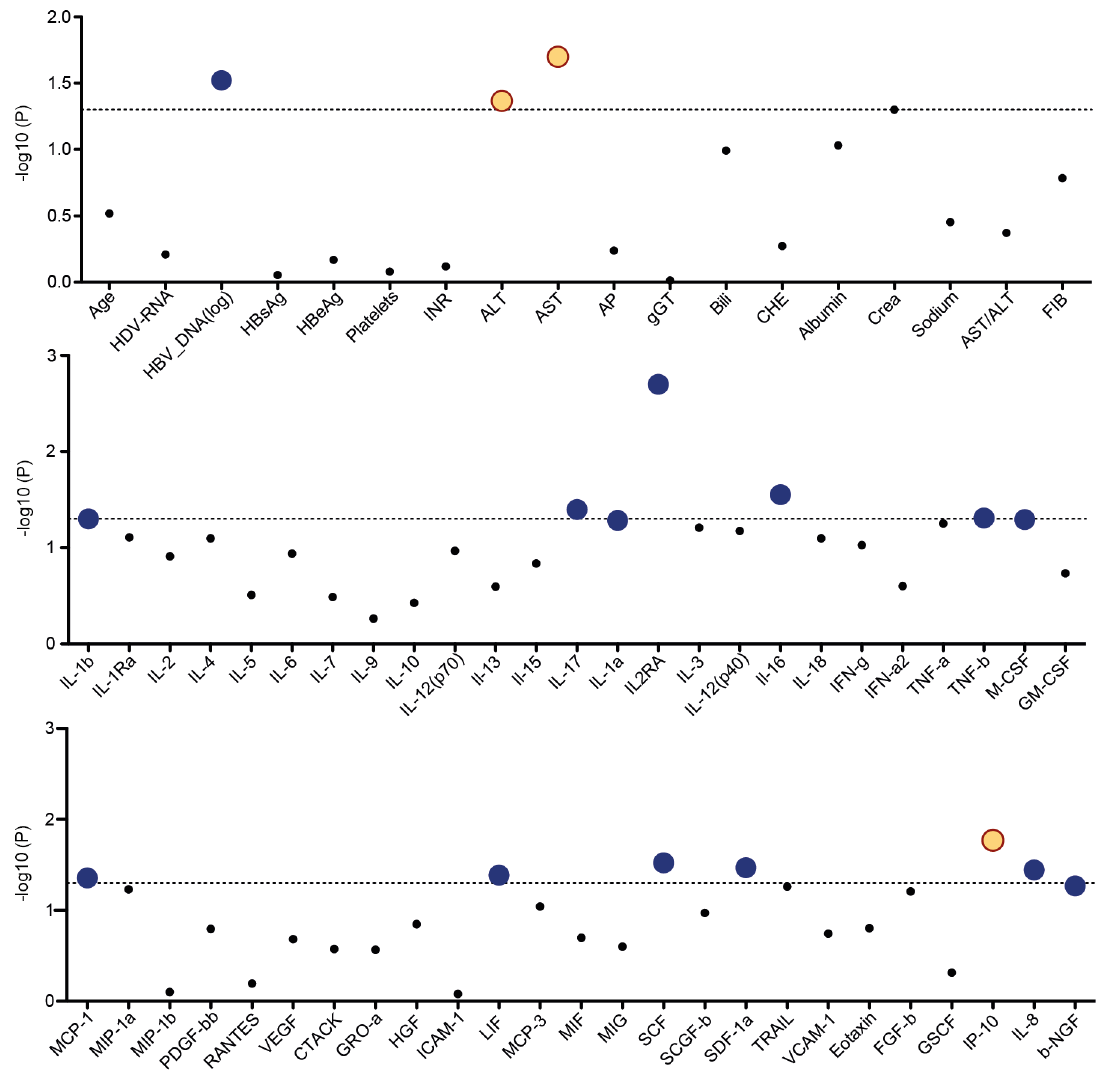
Figure 8. Factors associated with anti-HDV IgM based on univariate ANOVA testing in the HIDIT-2 cohort. The dashed line indicated a p-value of 0.05. All parameters above the line were determined as significantly associated with the four anti-HDV IgM groups. Dots in blue indicate low levels of the value in greater anti-HDV IgM groups while orange dots represent parameters with high levels in a great anti-HDV IgM group shown at x axis.